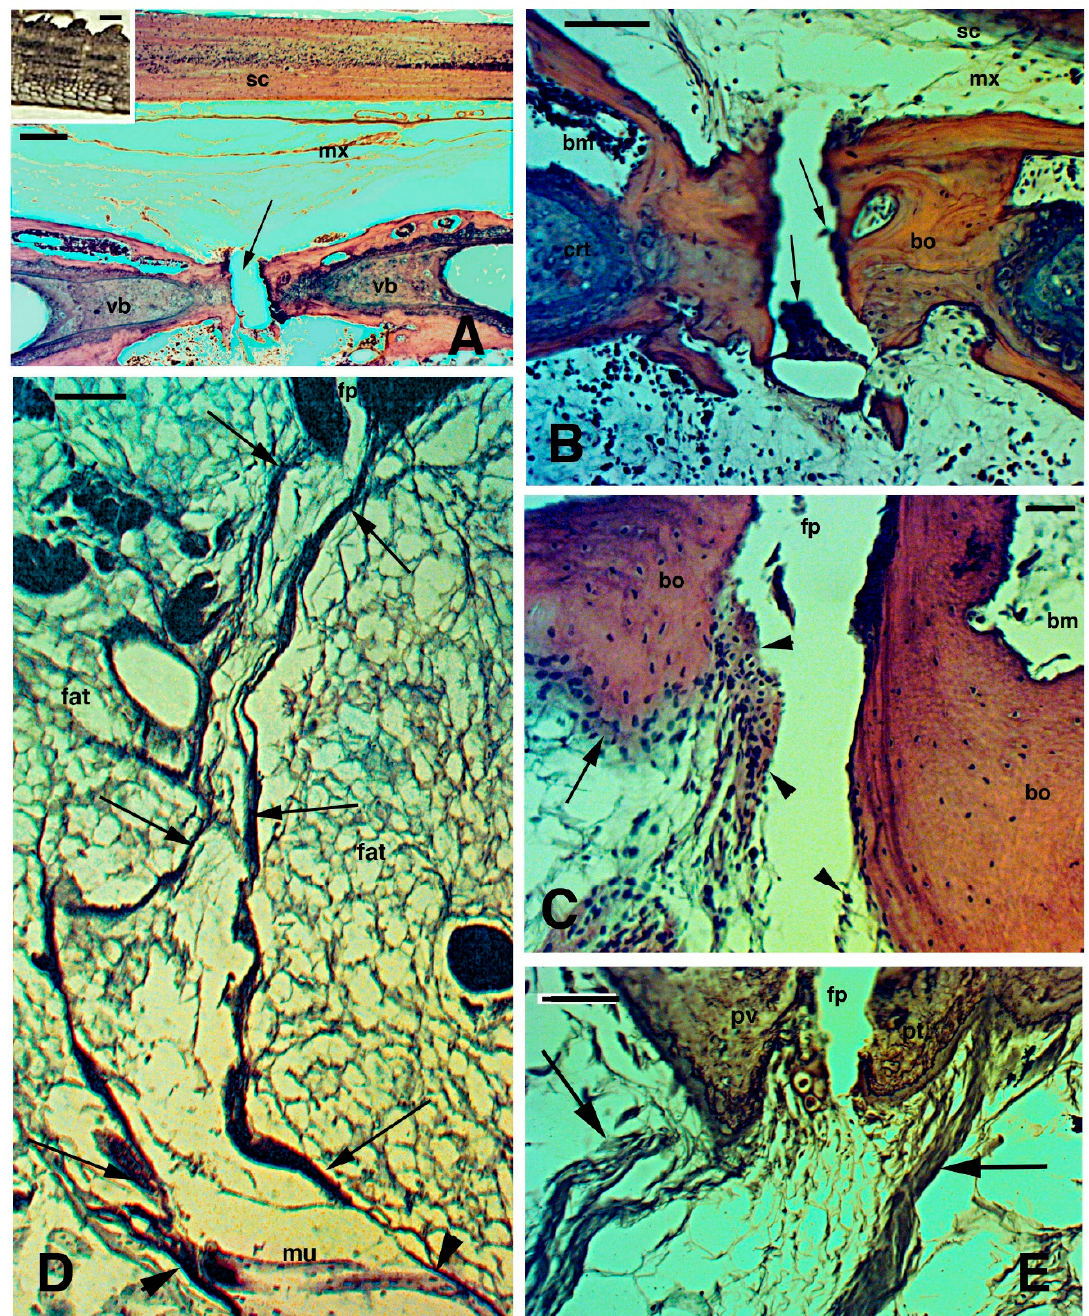
Figure 2. Histological images (stained with Haematoxylin-Eosin in ( A – C ), and Palmgreen stain in ( D , E )) of the caudal vertebrae of a normal tail in the tuatara (inset in Figure A , Bar, 2 mm). ( A ), image showing the spinal cord, meninx (artifactually dislocated after sectioning), and ventrally the vertebral body with the intra-vertebral fracture plane indicated (arrow), which has artifactually been separated during sectioning. Bar, 100µm. ( B ), closer view of fracture plane with fragments of blue-stained cartilaginous cells (arrows), probably dislocated from the articular surfaces during sectioning. Bar, 100µm. ( C ), close-up of the intra-vertebral splitting plane where numerous fibro-cartilaginous/connective cells (arrowheads) are present in continuation with the periosteum (arrow). Bar, 50µm. ( D ), peri-vertebral region rich in fat cells and loose connective showing two fibrous bundles (arrows) connecting pre- and post-vertebral bodies at the fracture plane to the inter-muscle connective septa (arrowheads). The image represents the plane of autotomy of the tail, which continues (not shown) into the dermis to externally reach the scales. Bar, 100µm. ( E ), detail of the fibrous bundles (ar- rows) connected to the pre-vertebral and post-vertebral bodies at the fracture or splitting autotomous plane. Bar, 50µm. Legends : bm, bone marrow; bo, vertebral bone; crt, cartilage; fp, fracture plane; mx, meninx; pt, post-vertebral body (more caudal) at the fracture plane; pv, pre-vertebral body (more rostral) at the fracture plane; sc, spinal cord; vb, verte-